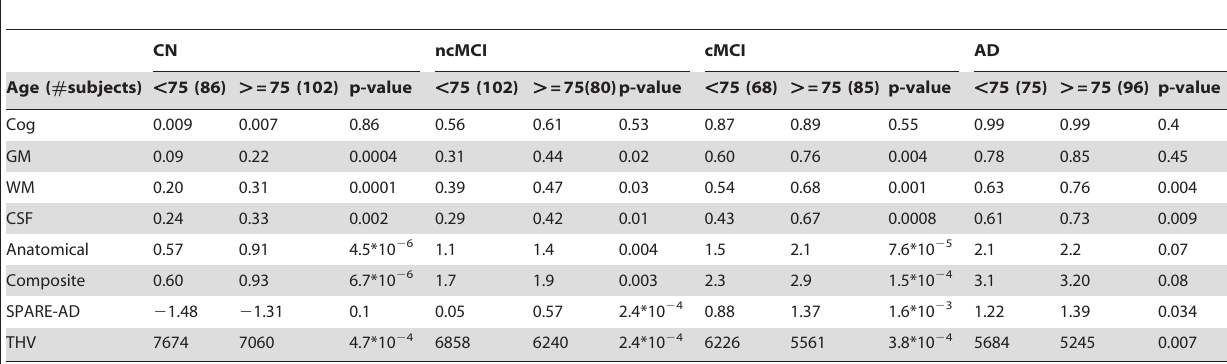
Table 6. Median values of AD-PS scores, SPARE-AD index and total hippocampal volume were estimated across cognitive status categories for ADNI participants, based on age ( , 75 yrs., vs. $ 75 yrs.).